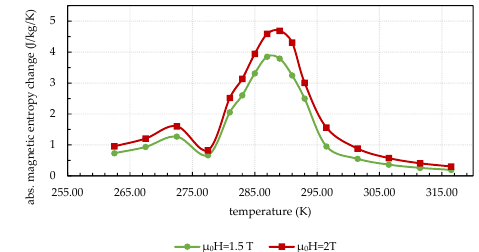
Figure 6. Magnetic and magnetocaloric properties of the LaFeSiMn-based magnetocaloric